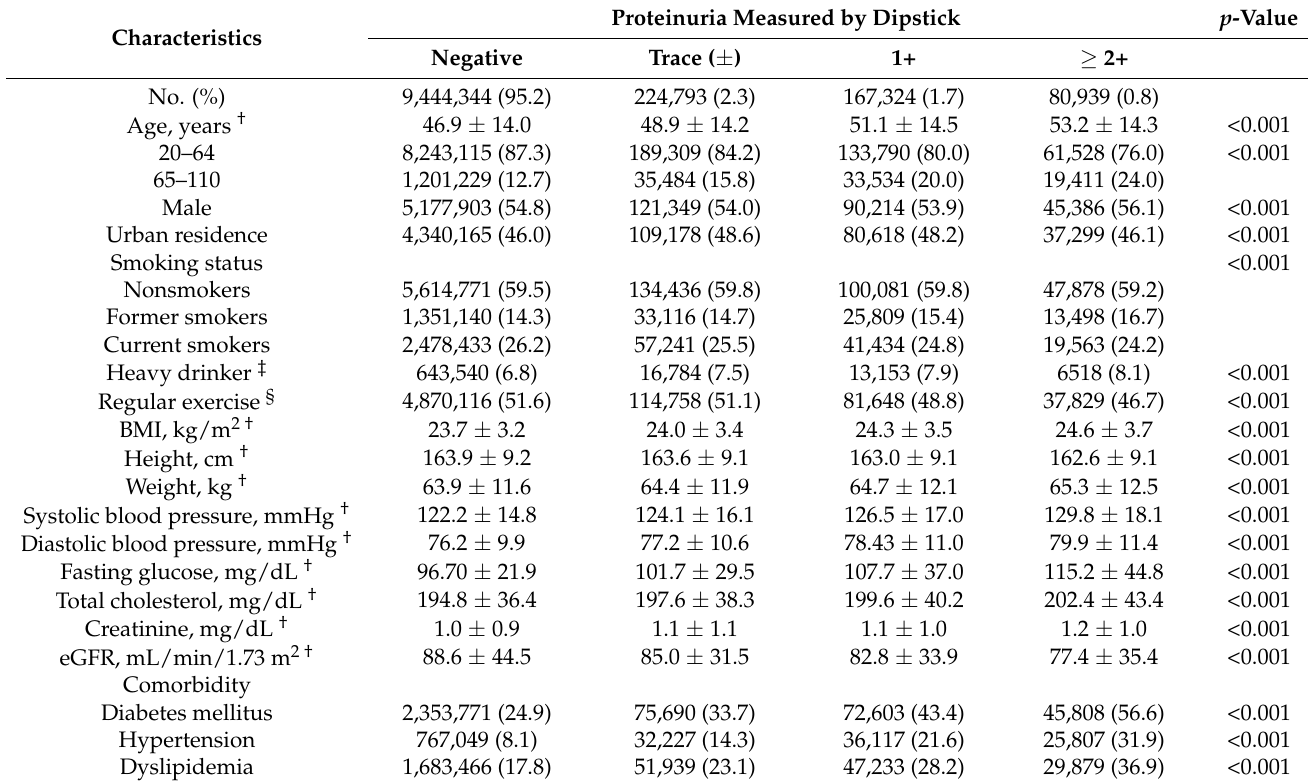
Table 1. Baseline characteristics of the study